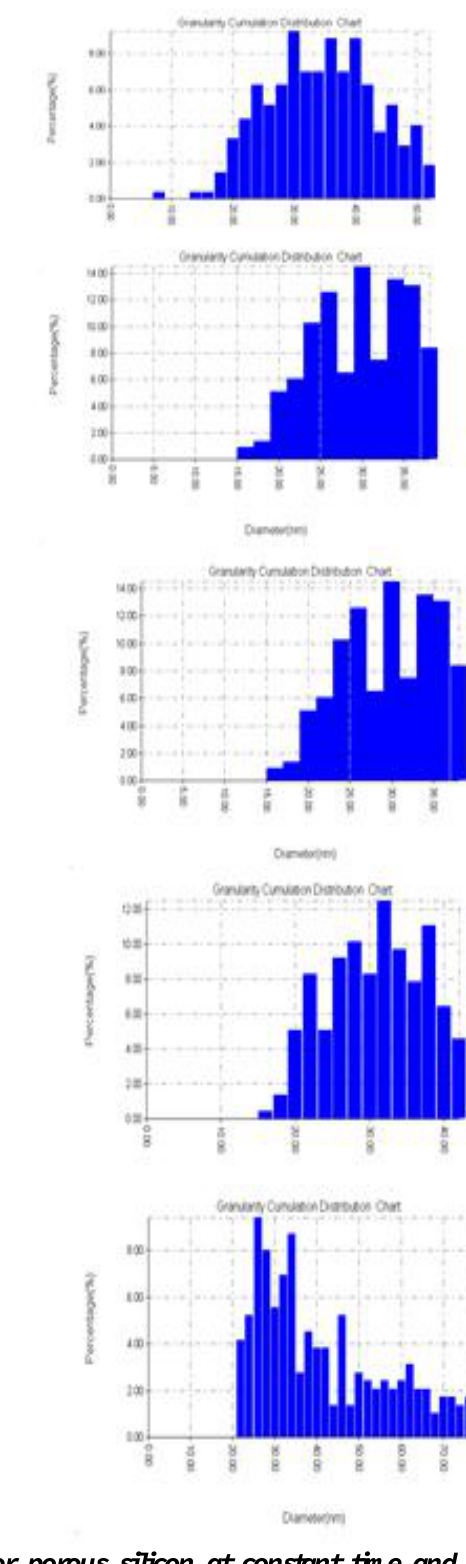
Fig. 4: 3D AFM images and size distribution for porous silicon at constant time and different etching current 10, 20, 30, 40 and 50